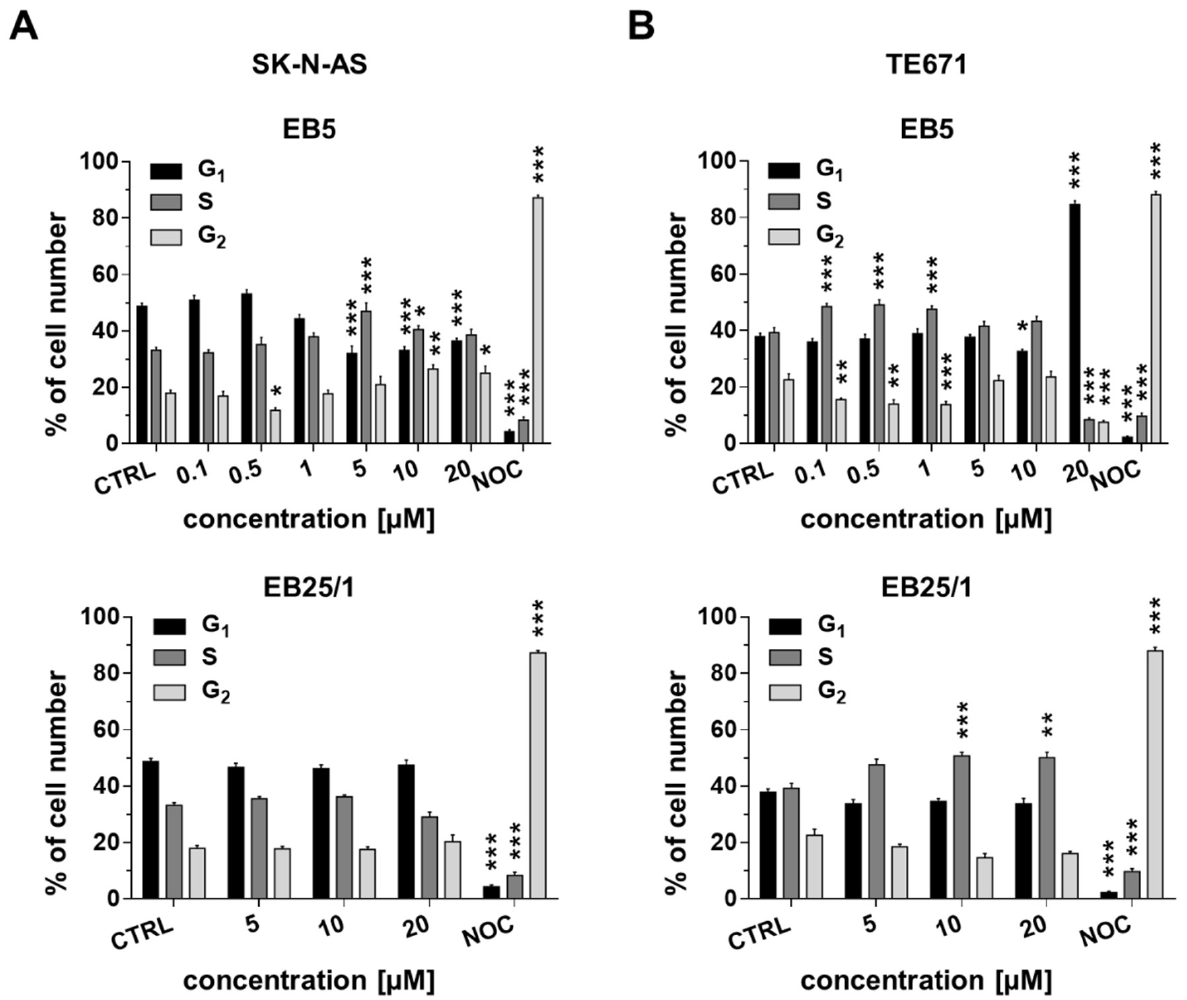
Figure 4. ASBDs inhibit cell cycle progression of pediatric cancer cells by affecting S phase. SK-N-AS and TE671 cell lines were treated with selected concentrations of ASBDs for 24 h, stained with PI, and then analyzed with FACS flow cytometry for cell cycle distribution. ( A ) The bar graphs present percentage of cells in phase G 1 , S and G 2 in SK-N-AS cells after treatment with EB5 (upper graph) and EB25/1 (bottom graph). ( B ) The bar graphs present percentage of cells in phase G 1 , S and G 2 in TE671 cells after treatment with EB5 (upper graph) and EB25/1 (bottom graph). Control cells (CTRL) were treated with 0.1% DMSO as a solvent control. Nocodazole (NOC, 5 µ g/mL) was used as a reference drug for induction of G 2 /M cell cycle arrest. The results represent the mean ± SEM of n = 10 from 5 independent experiments. Statistical significance was determined by two-way analysis of variance (ANOVA) followed by Dunnett’s post hoc test for multiple comparisons. p values were considered significant when p ≤ 0.05 (*, vs. CTRL), p ≤ 0.01 (**, vs. CTRL), p ≤ 0.001 (***, vs. CTRL).